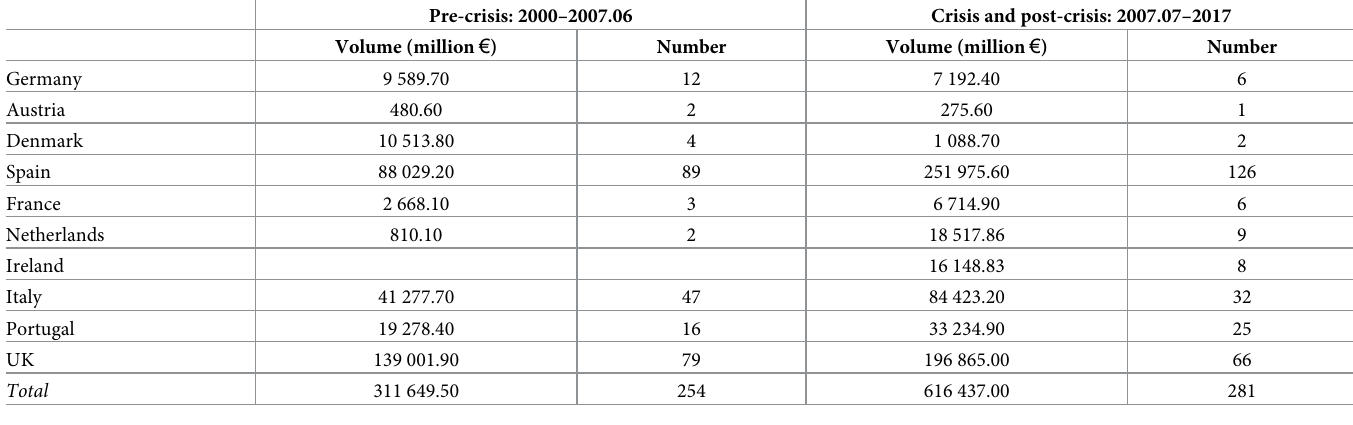
Table 1. Volume and number of issues by country; Pre-crisis and during the crisis. Pre-crisis: